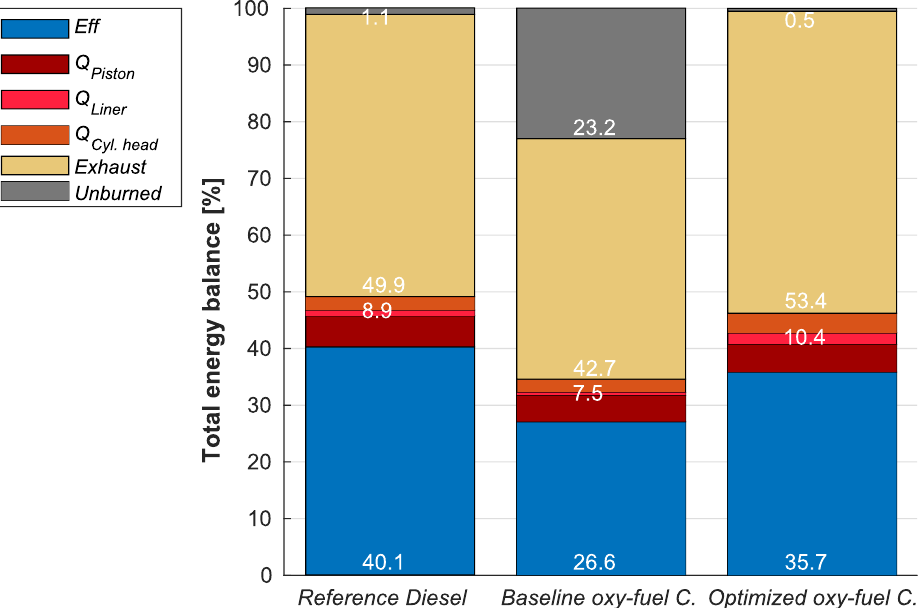
Figure 15. Energy balance for the three simulated cases.